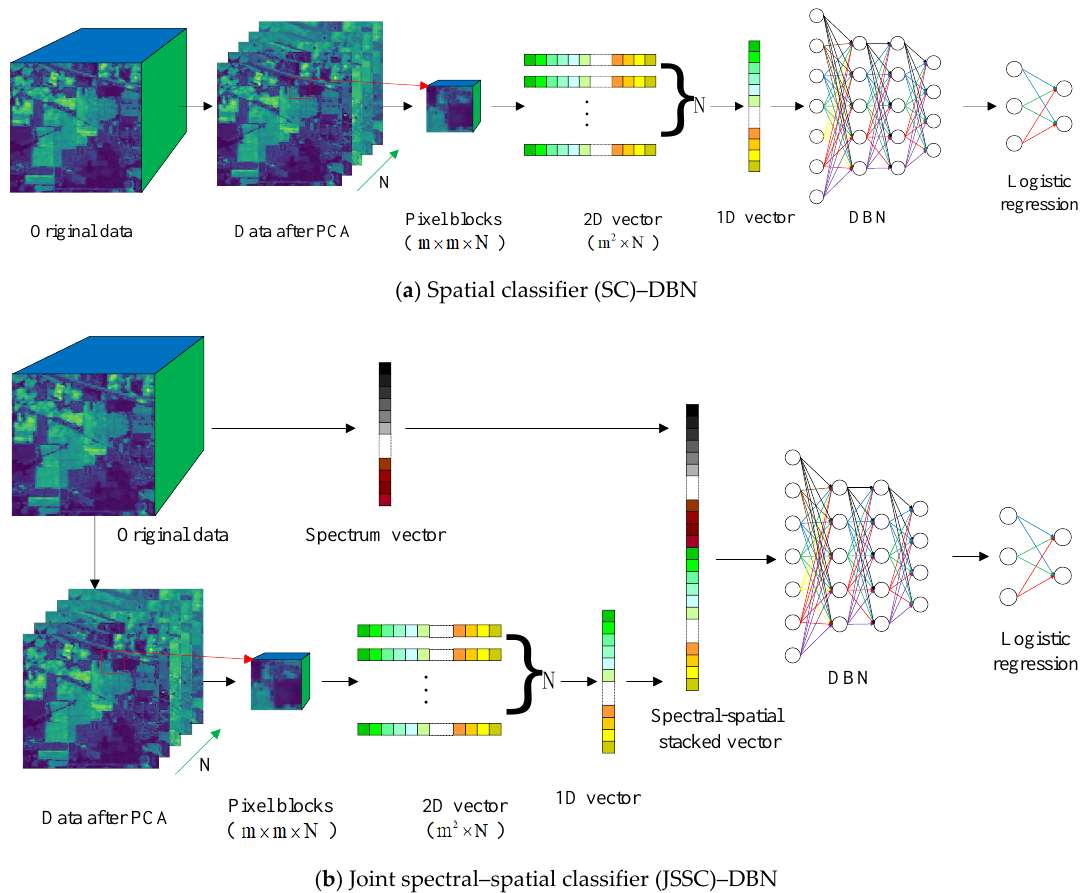
Figure 2. Process of hyperspectral classification based on DBN.